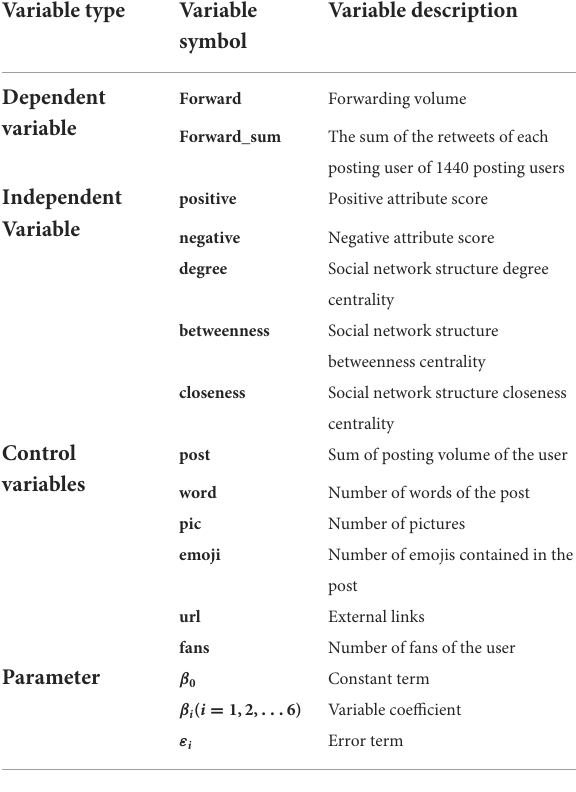
TABLE 2 Variables of sentiment analysis and social network